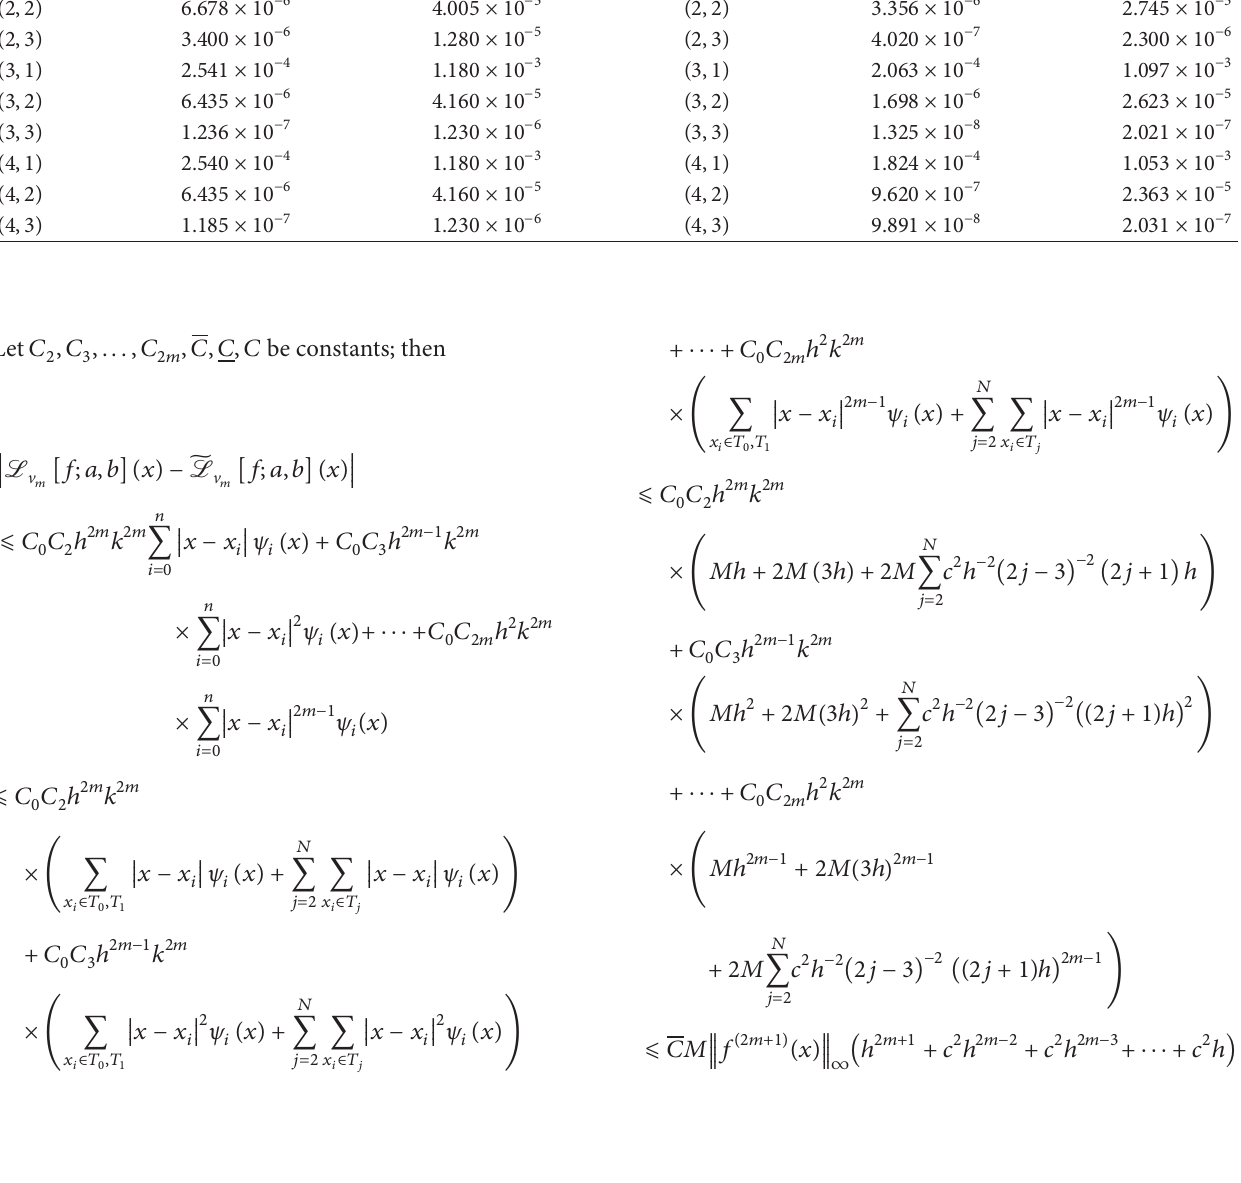
Table 2: Numerical results of the operators L 𝐻